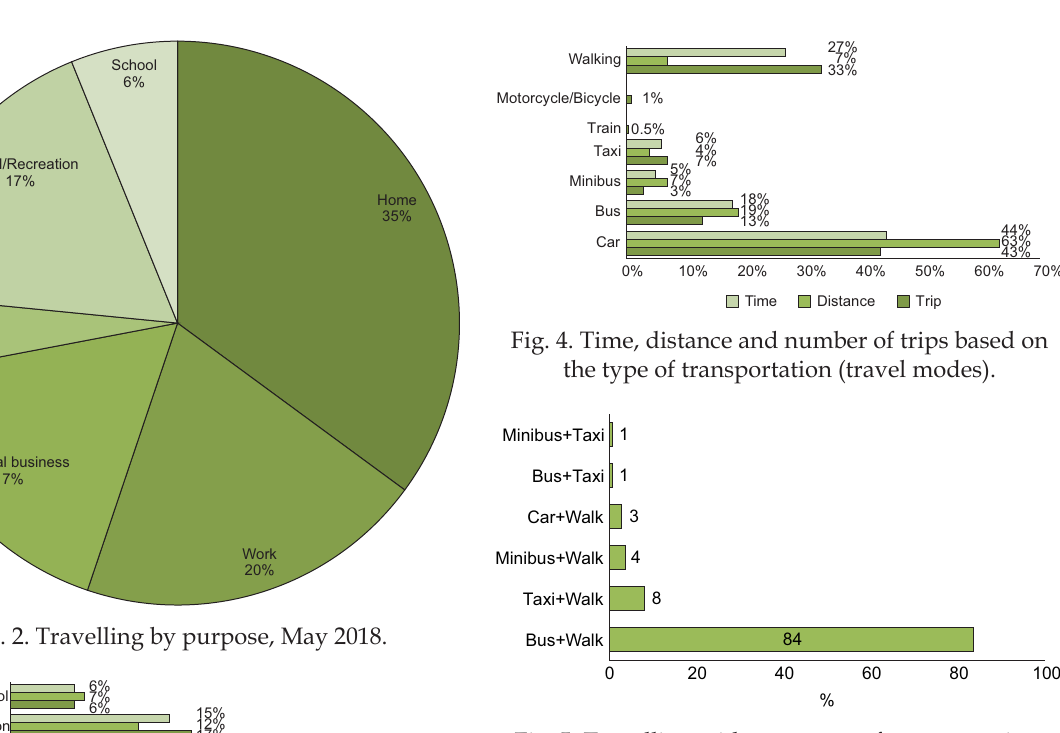
Fig. 5. Travelling with two types of